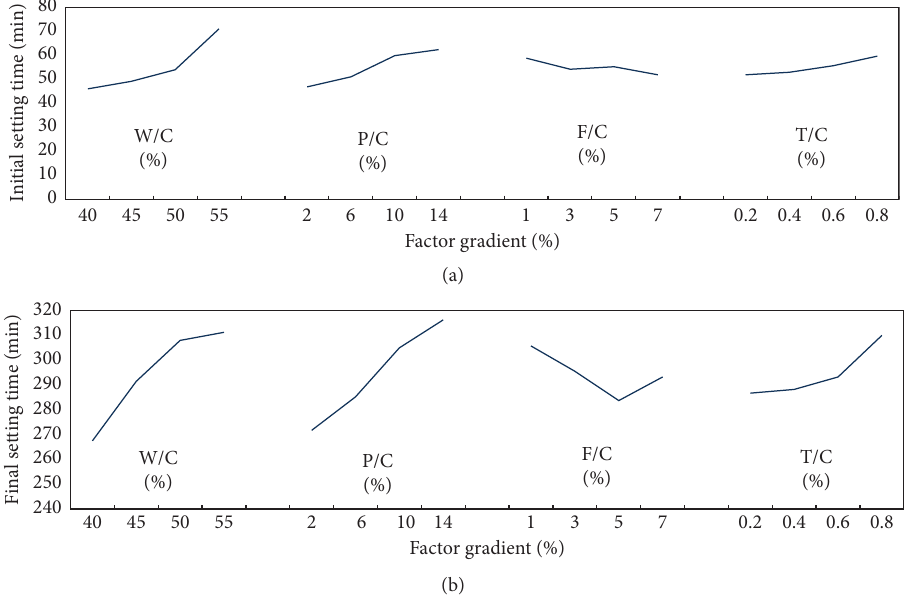
Figure 8: Setting time influence factor diagram. (a) Initial setting time factor influence diagram. (b) Final setting time factor influence diagram.